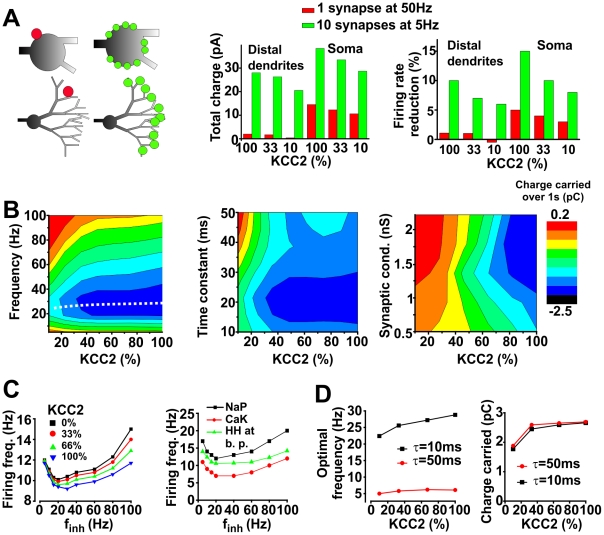
Efficacy of inhibition depends on spatial and temporal features of GABAAR input.
A. Schematic shows synapse positioning (left panel). GABAAR input clustered at a single synapse (red) produced less outward current than the same total input distributed across ten spatially separated synapses (green), especially for input to the distal dendrites (center panel). To ensure that “total charge” translates into functionally relevant inhibition (i.e. reduction in spiking), we submitted the model to distributed excitatory input (f
exc  =  0.2 Hz) and measured firing rate. As expected, reduction in firing frequency was greater when inhibitory input was spatially distributed (right panel). B. Net charge carried through a “test” synapse (color) consistently decreased as KCC2 activity was reduced, but increasing the frequency (left panel), time constant (middle panel) or conductance (right panel) of input at that synapse did not necessarily increase current amplitude. For the left panel, the time constant was held at 10 ms while the input frequency and KCC2 level were varied; the dotted line shows optimal frequency, which is re-plotted in D. For the middle panel, the input frequency was held at 30 Hz while the time constant and KCC2 level were varied. For the right panel input frequency and time constant were held at 30 Hz and 10 ms respectively while the conductance and KCC2 level were varied. Background synaptic activity was included in these simulations (f
inh  =  0.4 Hz, f
exc  =  0.1 Hz). Test synapse was positioned at 50 µm from the soma. C. We performed simulations similar to that in B but added distributed excitatory input to assess inhibition on the basis of firing rate reduction rather than on the basis of total charge (left panel). The pattern of inverted bell-shaped curves is consistent with B, thus confirming a net change in inhibition at the whole cell level. The graph on the right illustrates results obtained from simulations with models including Ca2+-activated K+ channels or persistent Na+ channels. We also concentrated dendritic HH channels at branch points while preserving the total conductance of these channels. Results were qualitatively the same as in the graph on the left. D. Optimal input frequency depending on KCC2 level and time constant (left panel) and the corresponding current (right panel). Black curves correspond to dotted line on left panel of B. Note that this is the optimal frequency for activation of a single “test” synapse; optimal input frequency would necessarily decrease as the number of activated synapses increased, although the exact relationship would depend on the spatial distribution of those active synapses (see A) as well as the level of background synaptic activity.